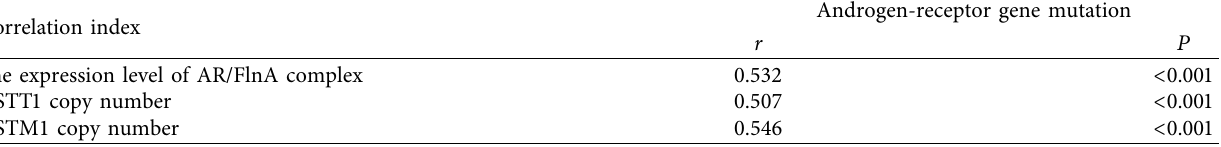
Table 8: Correlation